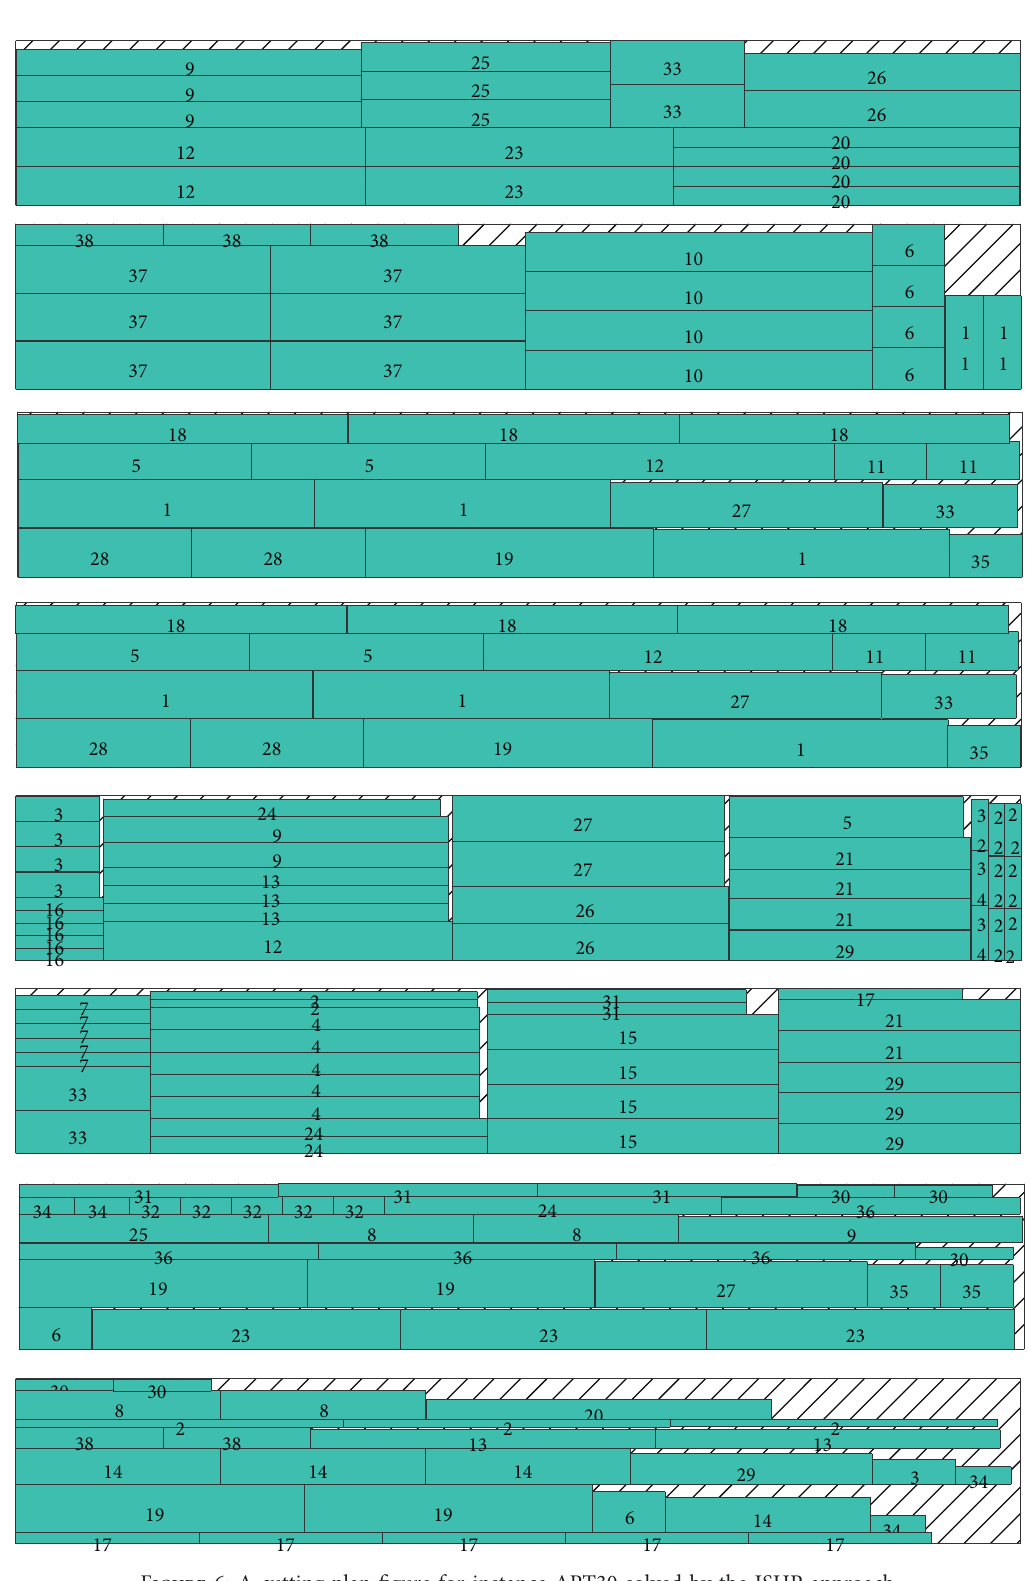
Figure 6: A cutting plan figure for instance APT30 solved by the ISHP